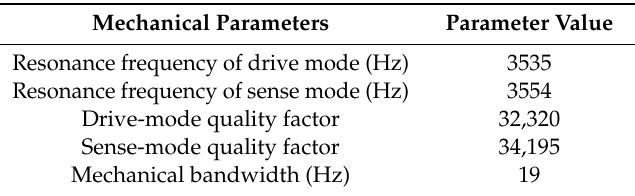
Table 1. Mechanical properties of sense elements.